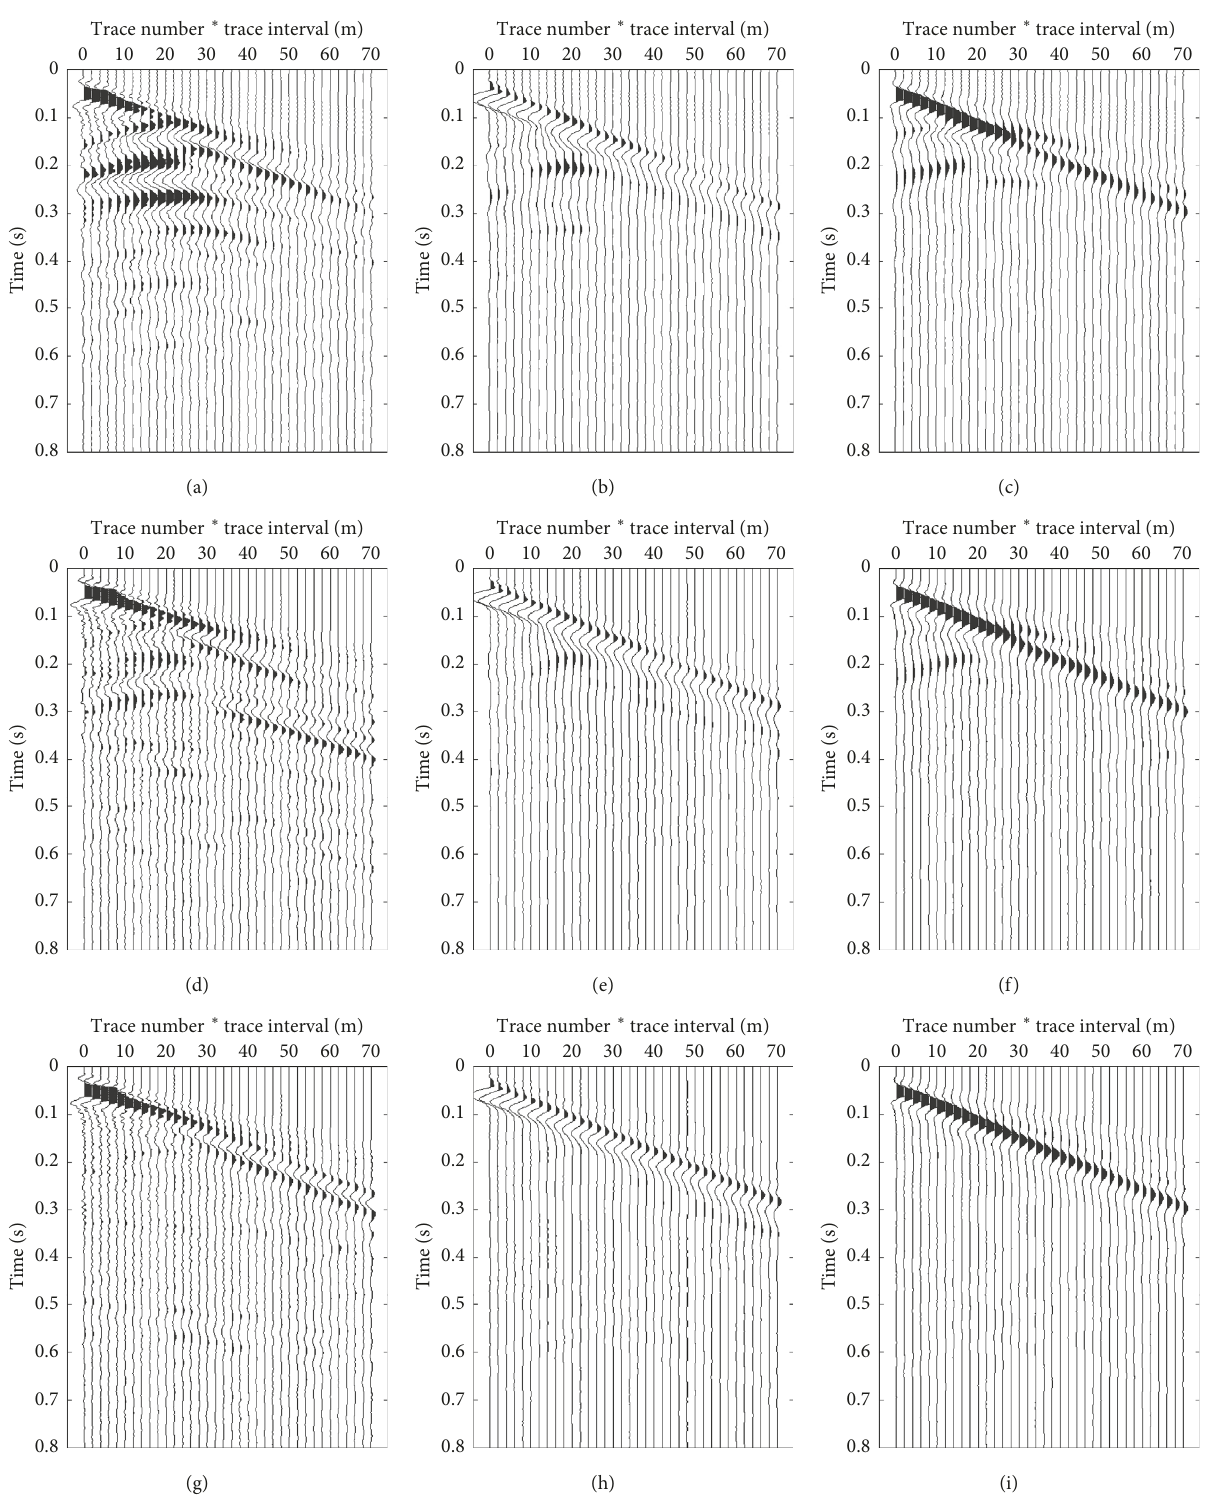
Figure 5: Time-history profile for measuring lines of earth-rock dam crests with different hazard characteristics. (a) Time-history profile for No. 1 material displacement in X direction. (b) Time-history profile for No. 1 material displacement in Y direction. (c) Time-history profile for No. 1 material displacement in Z direction. (d) Time-history profile for No. 4 material displacement in X direction. (e) Time-history profile for No. 4 material displacement in Y direction. (f) Time-history profile for No. 4 material displacement in Z direction. (g) Time- history profile for No. 6 material displacement in X direction. (h) Time-history profile for No. 6 material displacement in Y direction. (i) Time-history profile for No. 6 material displacement in Z